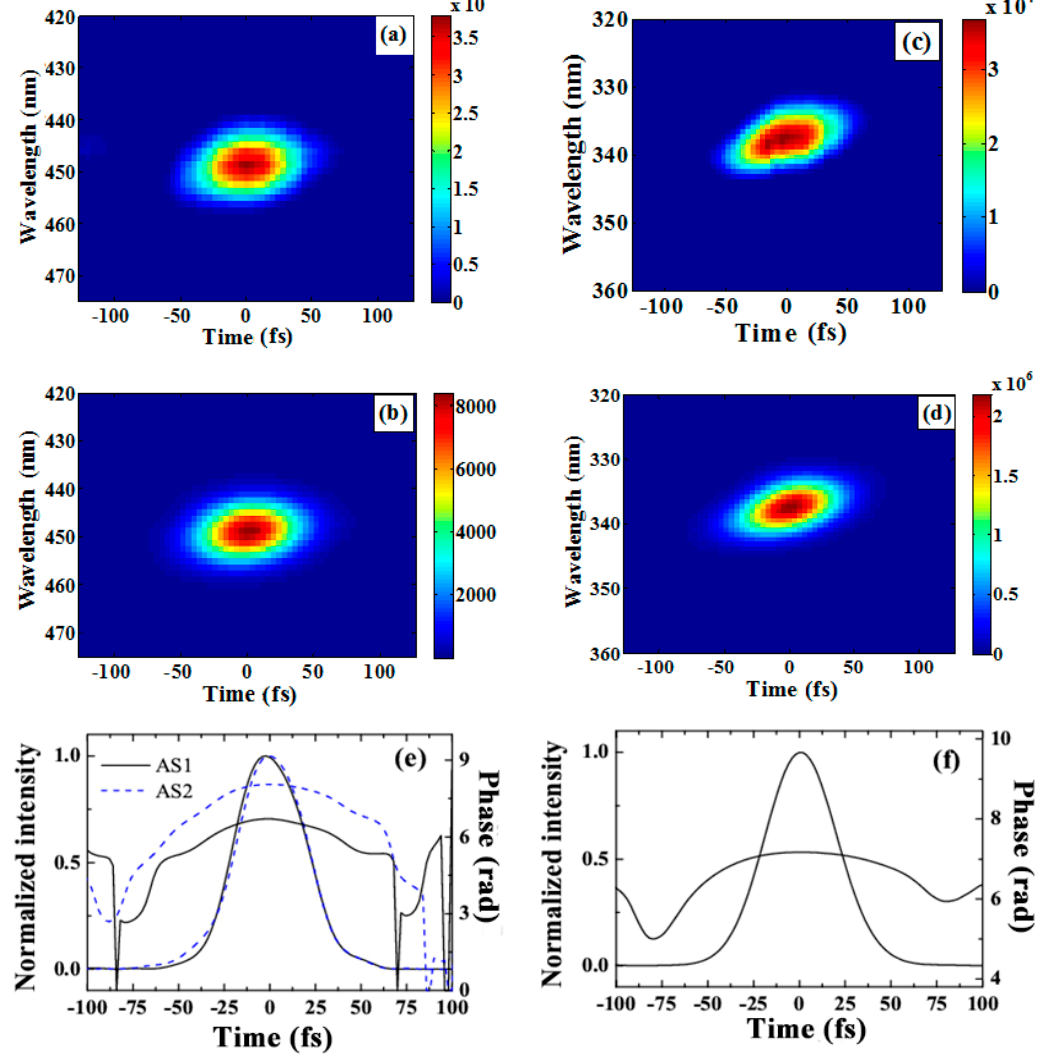
Figure 8. ( a ) Measured and ( b ) retrieved XFROG traces of S1; ( c ) measured and ( d ) retrieved XFROG traces of AS2 when the cross-angle was 1.87°. Retrieved temporal intensity profiles and phases of ( e ) AS1 (solid line), AS2 (dashed line) and ( f ) S1